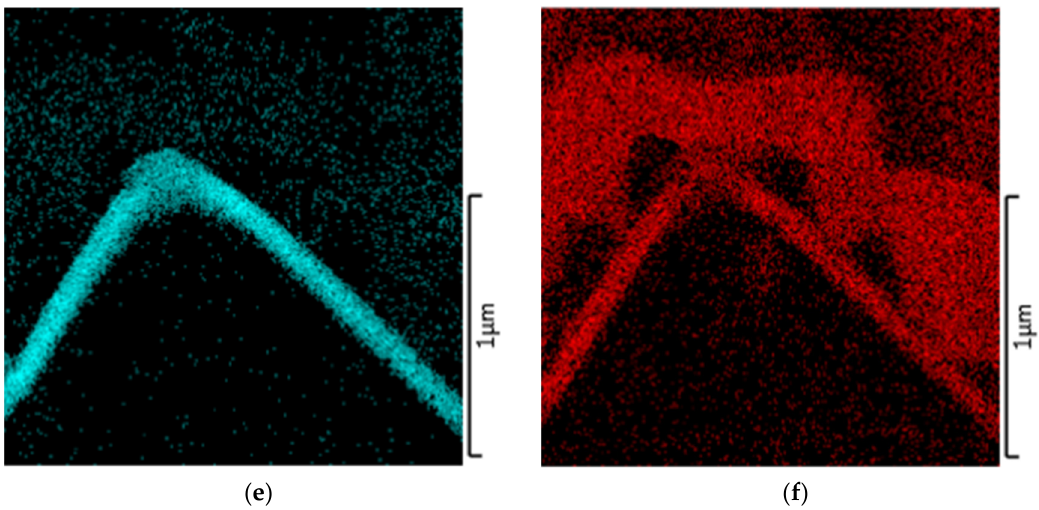
Figure 5. ( a ) TEM micrograph and ( b ) STEM micrograph for the sample annealed at 800 °C for 10 min. Additionally, EDS maps of ( c ) Si, ( d ) Cu, ( e ) Zn, and ( f ) O elements.